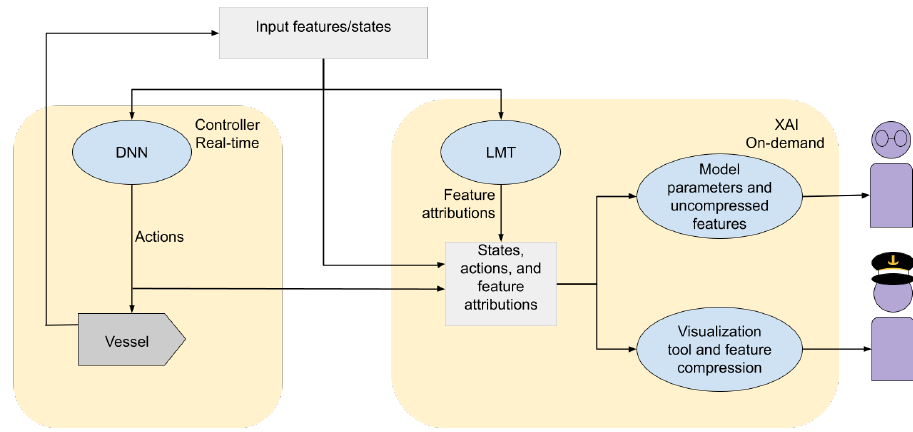
Figure 6. Pipeline after both the LMT and DNN are